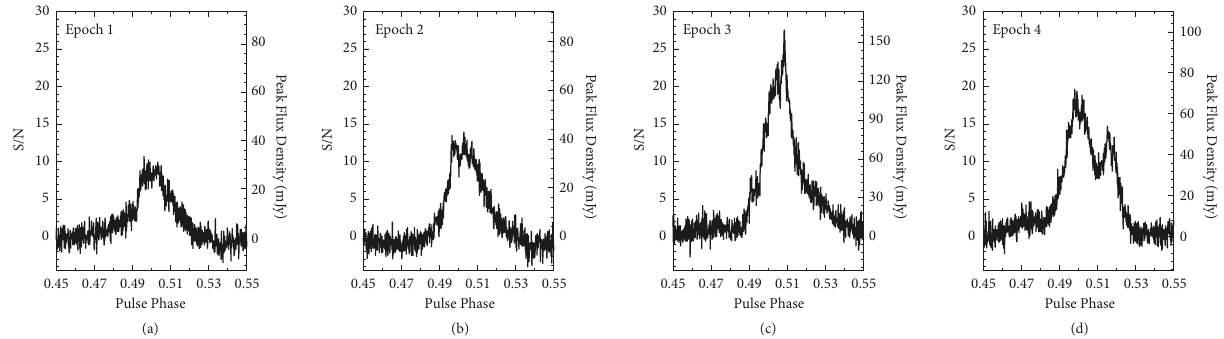
Figure 4: Average 𝑋 -band pulse profiles of the GC magnetar from observations with the 70 m DSN radio telescope, DSS-43, carried out on (a) 2015 July 30, (b) 2015 August 15, (c) 2016 April 1, and (d) 2016 August 20. This figure was adapted from Pearlman et al.